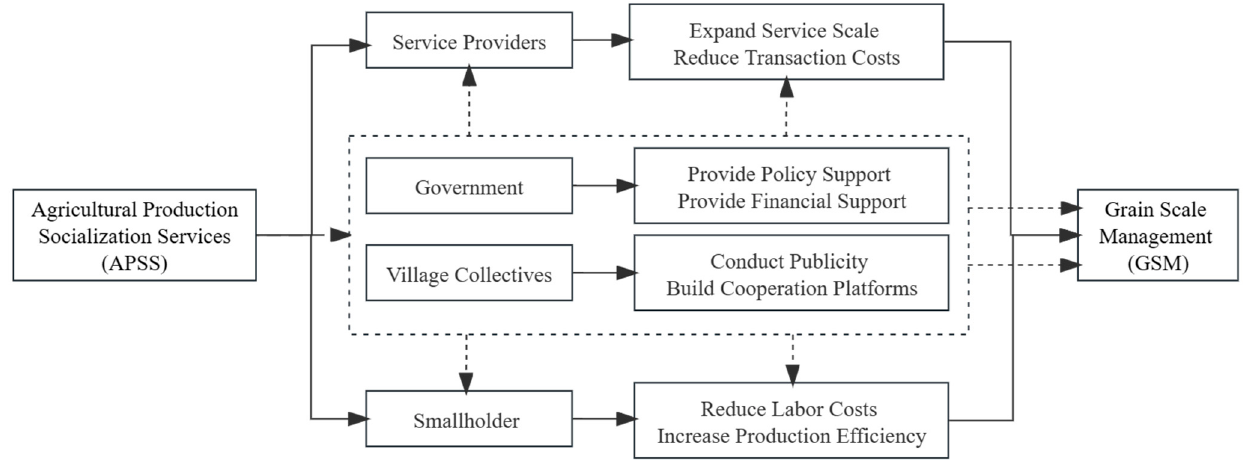
Figure 1. A Logical Framework for APSS to Promote GSM.